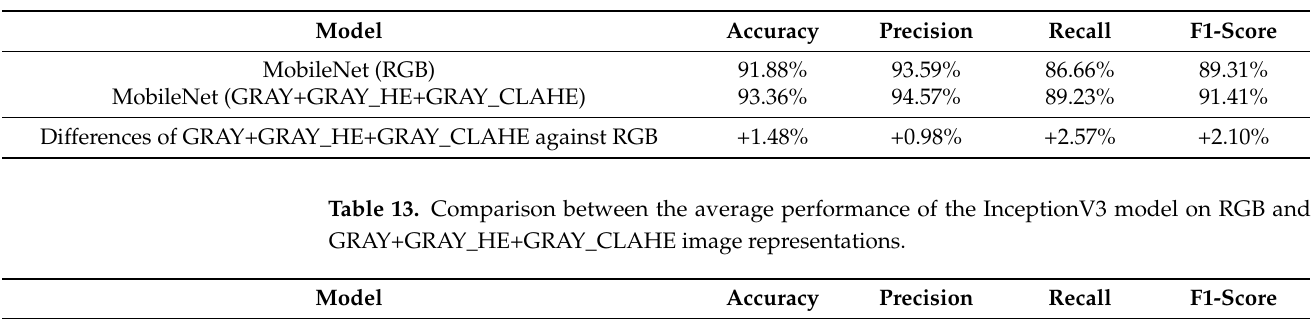
Table 12. Comparison between the average performance of MobileNet model on RGB and GRAY+GRAY_HE+GRAY_CLAHE image representations.